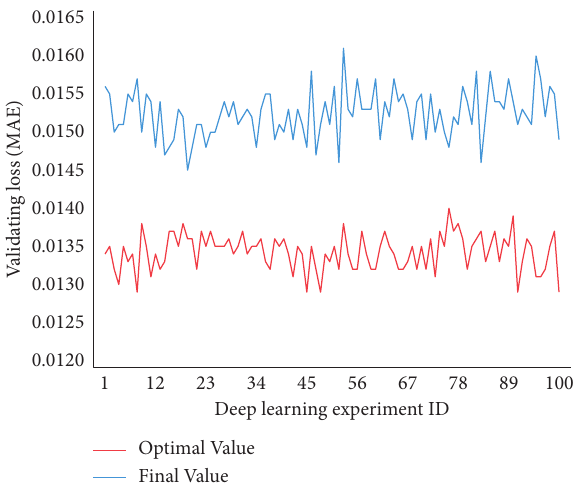
Figure 12: A comparison of optimal value and final value for validating loss by